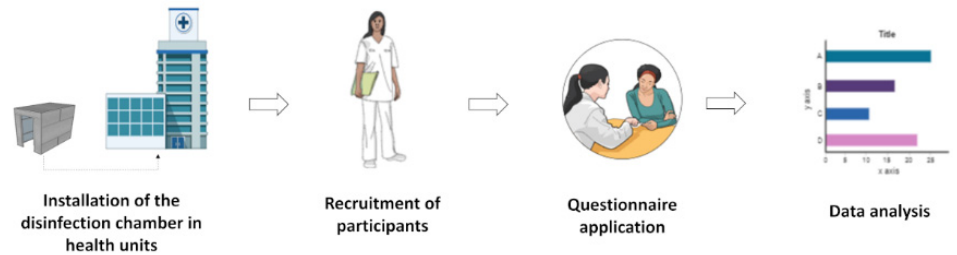
Figure 1. Stages of the study conducted to evaluate the perception of different professionals in hospitals and health units regarding the use of the disinfection chamber.